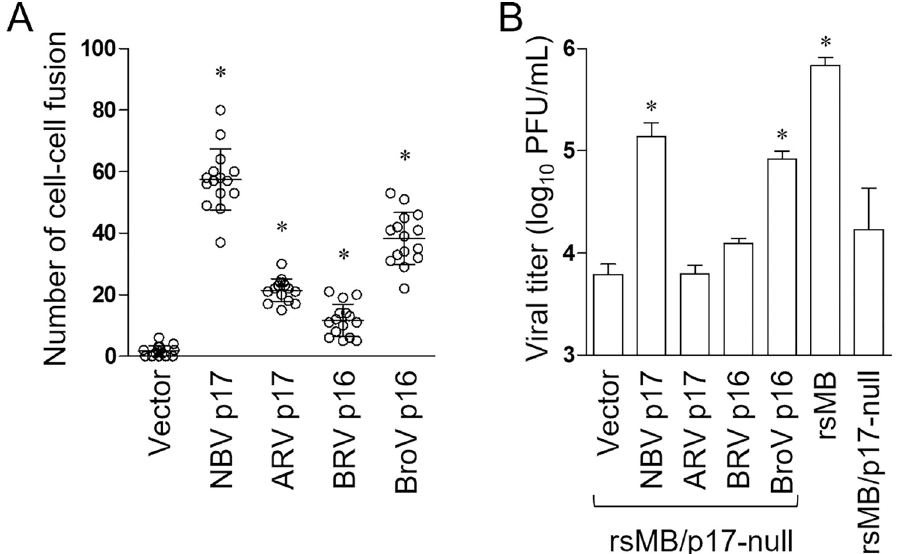
Fig 9. BroV p16 can restore rsMB/p17-null replication to complement cell–cell fusion activity in DemKT1 cells. (A) The number of cell–cell fusions in DemKT1 cells following NBV FAST co-expression with NBV p17, ARV p17, BRV p16, or BroV p16 in DemKT1 cells (n = 15). The number of fusion cells was counted in random microscopic fields (100 × total magnification). (B) Viral titers of rsMB/FAST-p17-null in DemKT1 cells co-expressing NBV FAST with NBV p17, ARV p17, BRV p16, or BroV p16. Transfected cells were infected with rsMB/FAST-p17-null at an MOI of 0.1 PFU/cell (n = 6) at 3 h post-transfection. Viral titers were determined by plaque assay at 24 h post-infection. Results are expressed as the mean of total samples. Error bars indicate standard deviations. Significant differences compared to the vector control are indicated by asterisks. � p < 0.05 (Dunnett’s test).